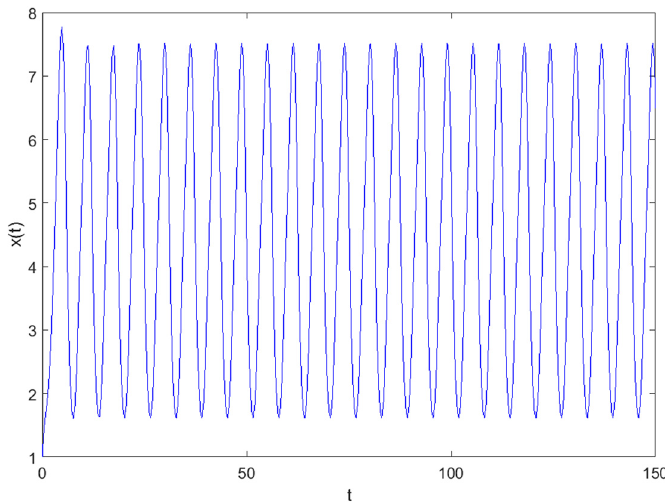
Figure 1: Numerical solution x t ( ) of equation ( 6.1 ) for initial value φ t 1 ( ) ≡ .